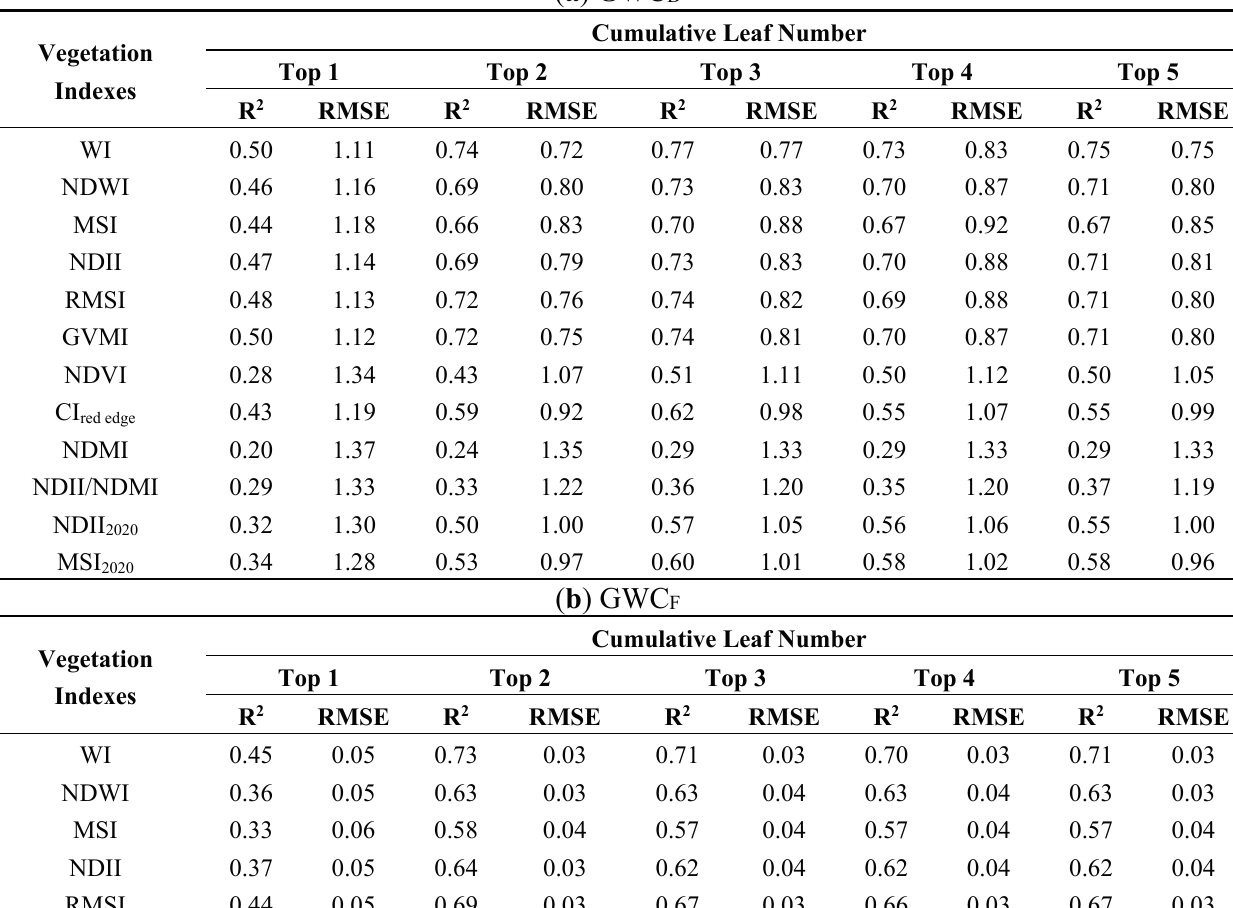
Table 8. Statistics of relationships between VIs based on canopy reflectance and GWC D ( a ), GWC F ( b ), RWC ( c ), and EWT ( d ) for the cumulative leaf number within the winter wheat canopy. The significant relationships ( p < 0.001) were indicated by R 2 values greater than 0.29 (33